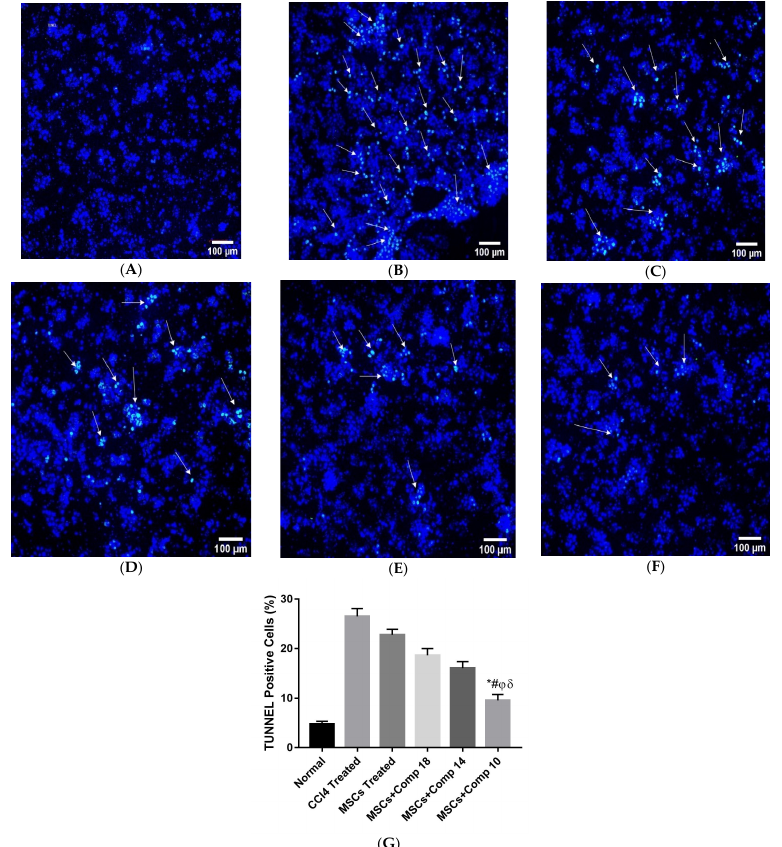
Figure 6. Assessment of apoptosis in experimental models using the TUNEL apoptotic. Assay in all experimental models ( A – F ). TUNEL apoptotic cells are shown by positive nuclei (green) in liver slices: ( A ) normal, ( B ) CCl 4 ‐ treated, ( C ) MSCs ‐ treated, ( D ) MSCs + compound ( 18 ) ‐ treated, ( E ) MSCs + compound ( 14 ) ‐ treated, ( F ) MSCs + compounds ( 10 ) ‐ treated, ( G ) graphical representation of TUNEL ‐ positive cells. Among all treated animal models, MSC + compound ( 10 ) ‐ treated rat model showed the most reduced apoptotic cells , as shown by bars with symbols *. Mean ± SEM (n = 3). Bars with symbols show significance with each other. * p < 0.02 for MSCs + Comp10 vs. CCl4; # p < 0.05 for MSCs + Comp10 vs. MSCs; φ p < 0.05 for MSCs + Comp10 vs. MSCs + Comp18; δ p < 0.05 for MSCs + Comp10 vs. MSCs + Comp18. To stain the nu ‐ clei (Blue) DAPI was used (20×; scale bar: 100 μ m).